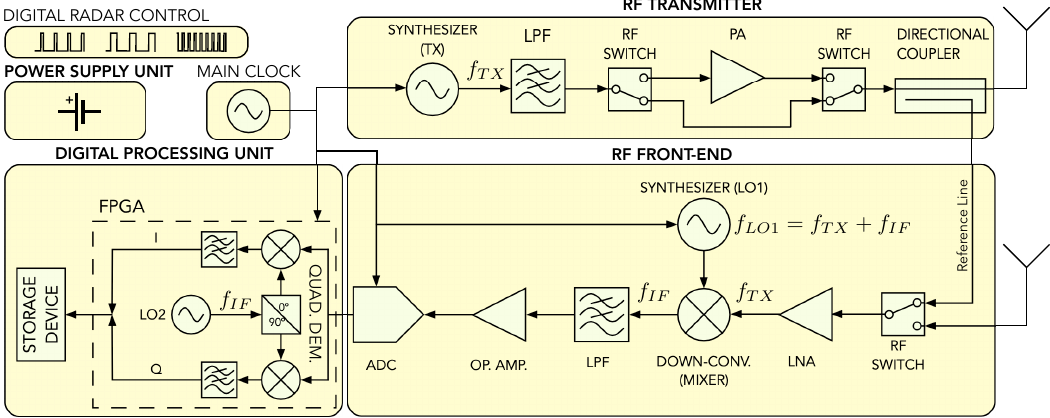
Figure 2. Block scheme of the proposed SFCW Ground Penetrating Radar (GPR) board with indicated main system